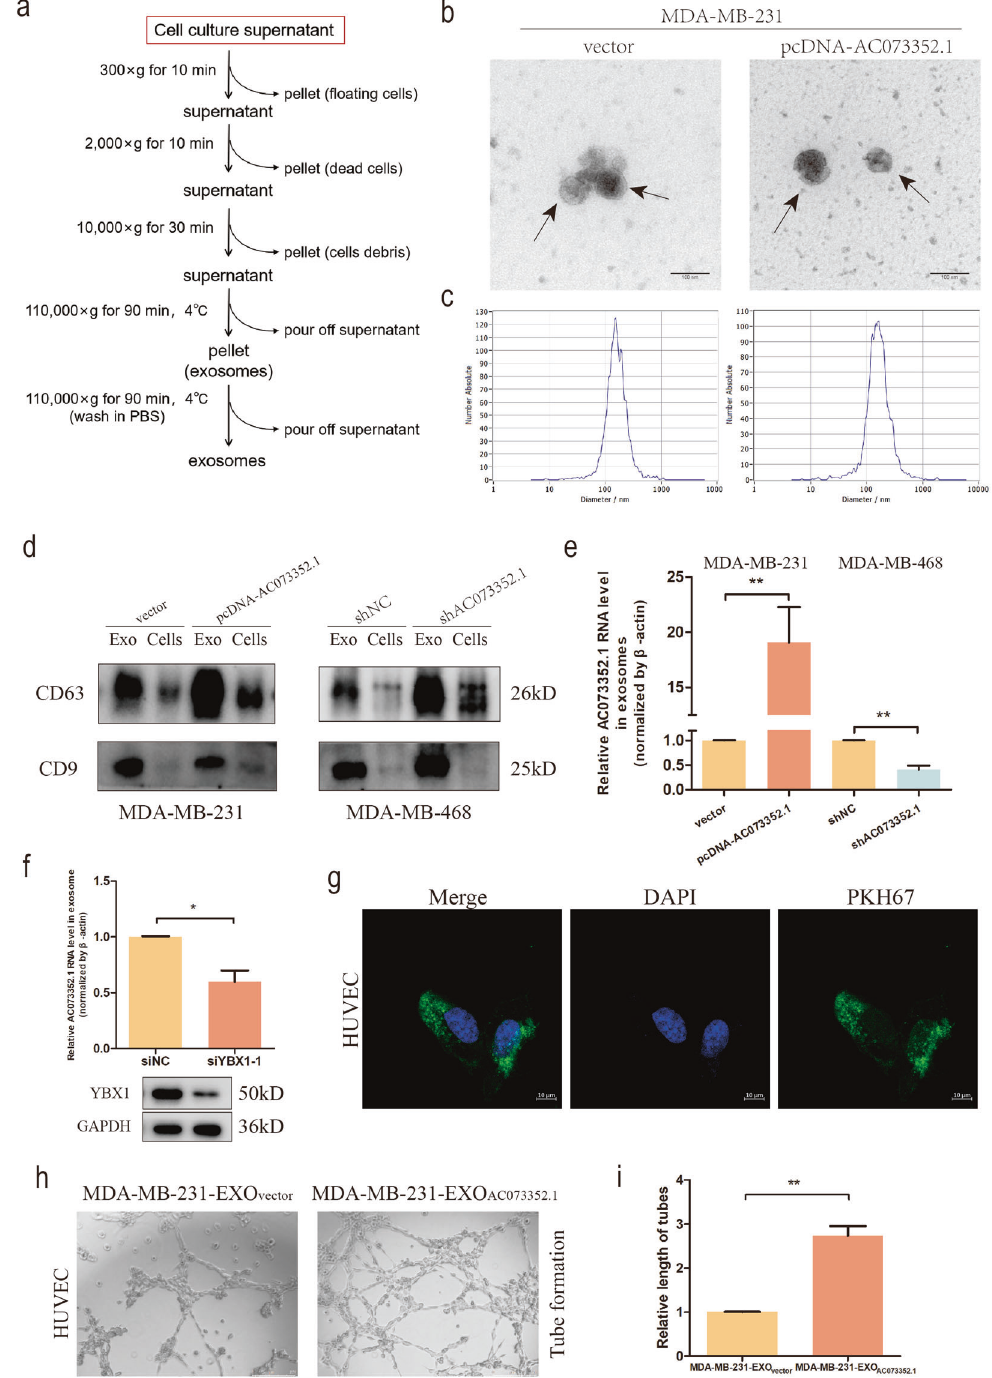
Fig. 7 Exosomal AC073352.1 regulates the angiogenesis of HUVECs via binding YBX1. a Flow chart for the exosome puri fi cation procedure based on differential ultracentrifugation. b TEM scanning images of puri fi ed exosomes derived from MDA-MB-231 cells overexpressing AC073352.1. Scale bars: 100 nm. c Characterization of puri fi ed exosomes derived from MDA-MB-231 cells overexpressing AC073352.1. The size, number, and distribution of exosomes was analyzed by NTA. d Exosomal protein marker (CD63 and CD9) detection by western blot from puri fi ed exosomes and exosome-depleted cell extracts. e qRT-PCR analysis of AC073352.1 levels in exosomes from AC073352.1- overexpressing MDA-MB-231 cells and shAC073352.1-treated MDA-MB-468 cells. f qRT-PCR analysis of AC073352.1 levels: AC073352.1 levels were decreased in exosomes after MDA-MB-231 cells were transfected with a YBX1 siRNA. g HUVECs were incubated with PKH67-lableled exosomes for intercellular traf fi cking. Scale bars: 10 μ m. h , i Representative images and quanti fi cation of tube-formation assays by HUVECs treated with MDA-MB-231 vector or MDA-MB-231 AC073352.1 . Scale bars: 100 μ m. * p < 0.05 and ** p <